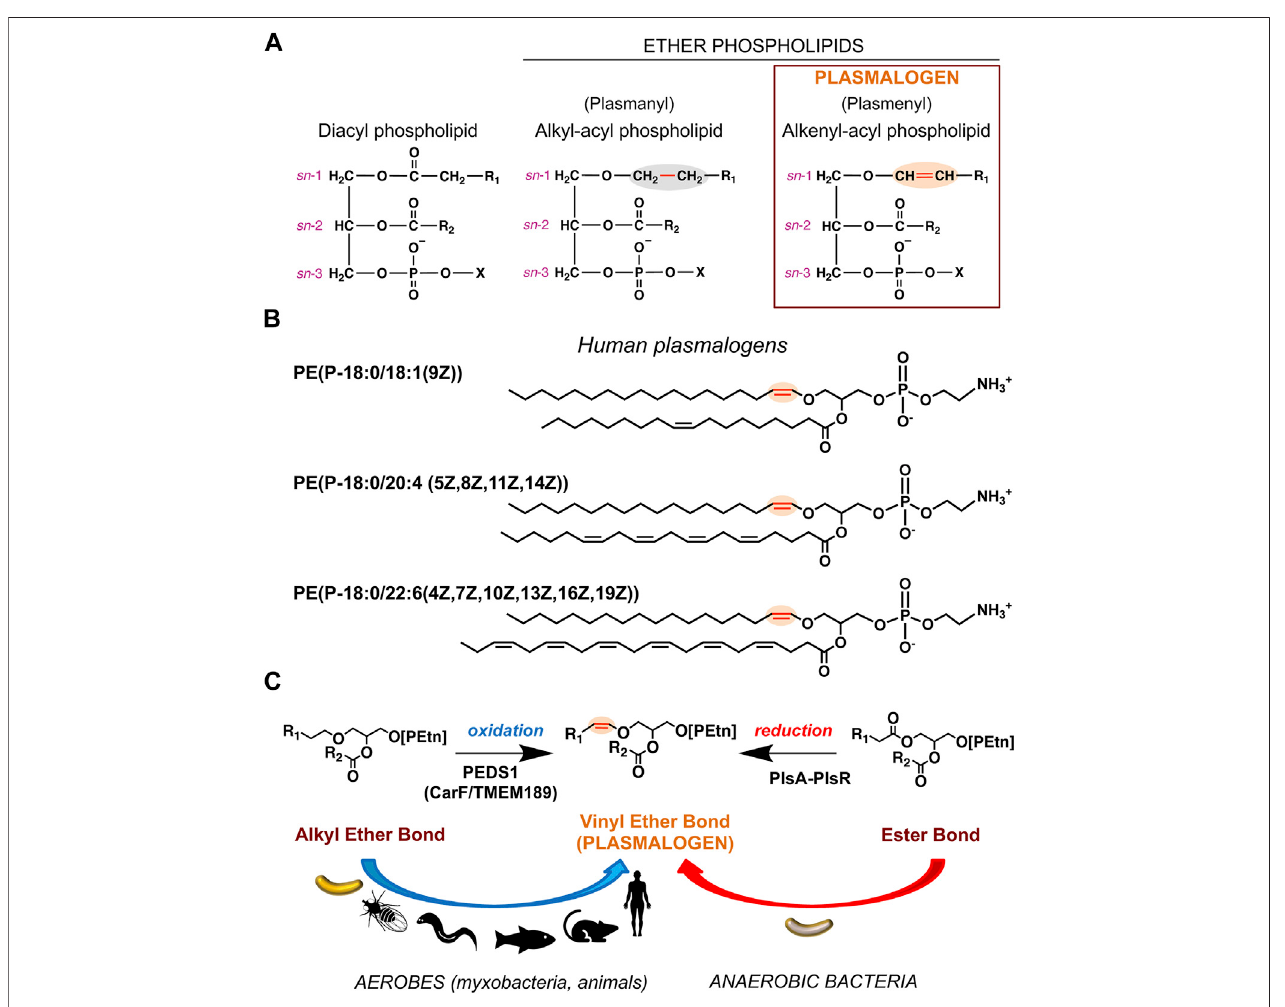
FIGURE1| Chemicalstructuresofplasmalogensandgenerationofthehallmarkvinyletherbond. (A) ChemicalstructuresrepresentedasFischerprojectionsofthe ester-linkeddiacylglycerophospholipids(left),alkyletherlipids(middle),andvinyletherlipidsorplasmalogens(right).Thevinyletheranditsprecursoralkyletherbondare highlighted in red and shaded orange and grey, respectively; sn positions are indicated; R 1 and R 2 represent hydrocarbon chains at the sn -1 and sn -2 positions, respectively; X = ethanolamine (Etn) or choline (Cho) moiety. (B) Representative human plasmalogens. PE (P-18:0/18:1 (9Z)) or 1-(1Z-octadecenyl)-2-(9Z- octadecenoyl)-sn-glycero-3-phosphoethanolamine; PE (P-18:0/20:4 (5Z,8Z,11Z,14Z)) or 1-(1Z-octadecenyl)-2-(5Z,8Z,11Z,14Z-eicosatetraenoyl)-sn-glycero-3- phosphoethanolamine(5Z,8Z,11Z,14Z-eicosatetraenoyl=arachidonyl); PE(P-18:0/22:6(4Z,7Z,10Z,13Z,16Z,19Z))or1-(1Z-octadecenyl)-2-(4Z,7Z,10Z,13Z,16Z,19Z- docosahexaenoyl)-sn-glycero-3-phosphoethanolamine. LIPID MAPS Structure Database (https://www.lipidmaps.org/databases/lmsd) common and systematic names are used. (C) Vinyl ether bond formation in plasmalogens by the aerobic (oxidative) pathway in myxobacteria and animals and the anaerobic (reductive) route in anaerobic